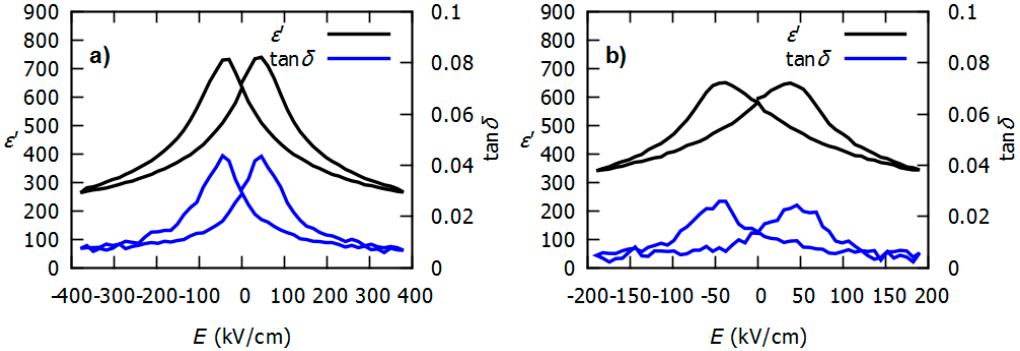
Figure 4. Relative permittivity ε’ and tan δ at 1 kHz versus DC electric field E of a 7-tooth IDE structure with a 5 μm gap. Electrodes are made of ( a ) AZO and ( b ) Pt. For permittivity calculation, the stray capacitance was subtracted from the measured capacitance.